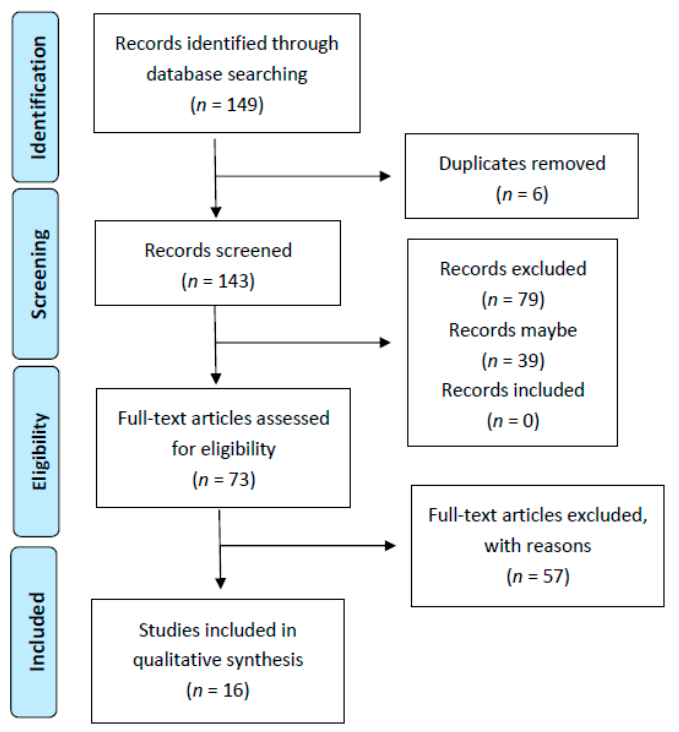
Figure 1. Flowchart of the search process.